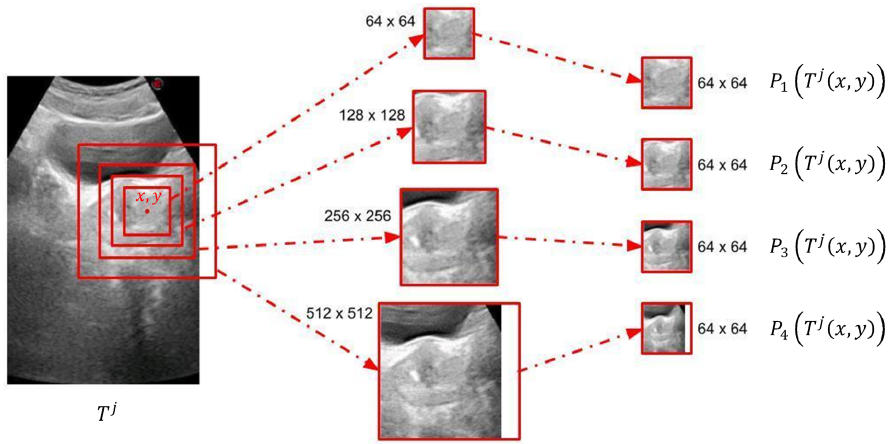
Figure 3. Patch-extraction process. For a given image location T j ( x , y ) of patient j , patches from four different scales centering ( x , y ) were extracted. All of them were downsized to the smallest scale, and the quadruplet patch PQ ( T j ( x , y )) was